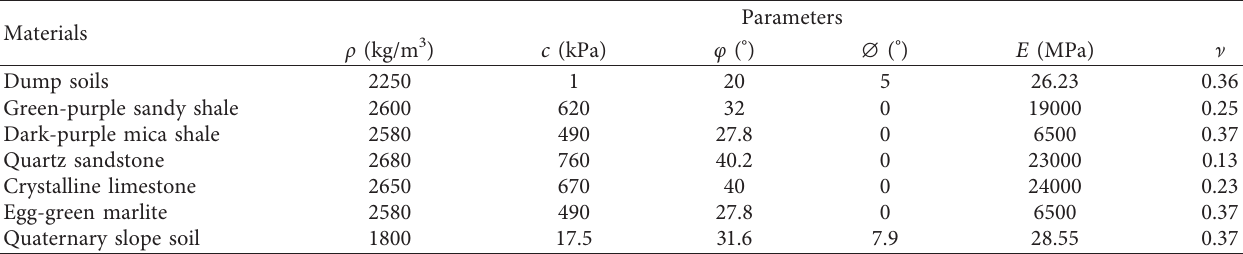
Figure 10: The simulation zone of the full high waste dump by the SPH method. Table 4: The material properties of the SPH model [9].